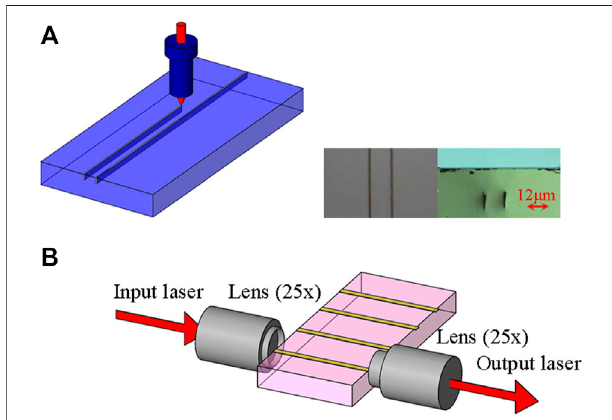
FIGURE 1 | (A) Laser writing setup used in Yb:YVO 4 crystals (left); Schematic photographs of the buried channel waveguide structures in Yb: YVO 4 crystals (right) cross section and top section; (B) Endface coupling setup at 633 nm.